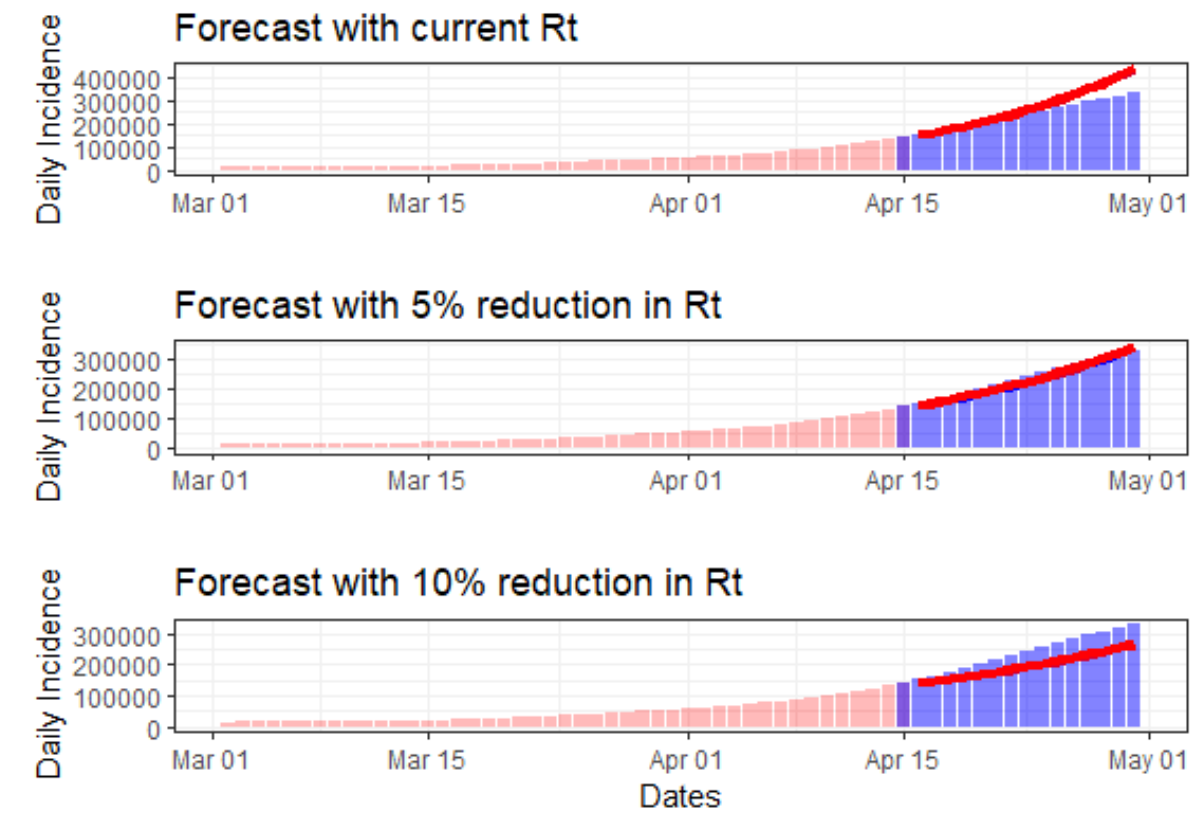
Figure 3. Projections of future daily incidence from 15th April 2021 to 30th April 2021. The projections are represented as a thick red line, while the observed cases are represented as blue columns on the x-axis. The light red columns on the x-axis represent the previous cases based on which the projections are